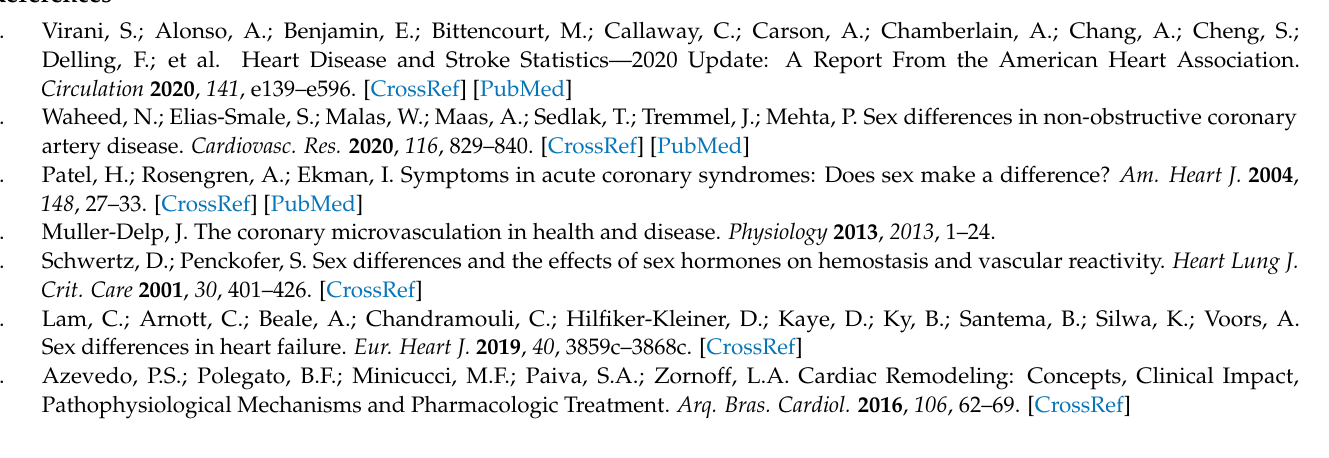
Inflammation, Table S3: Berry Polyphenols and Oxidative Stress, Table S4: Berry Polyphenols and Pathological